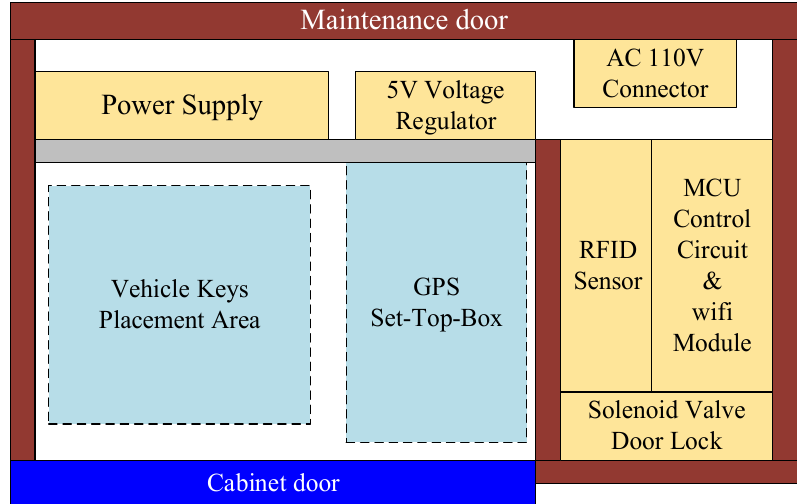
Figure 9. Layout of the interior of the key cabinet.